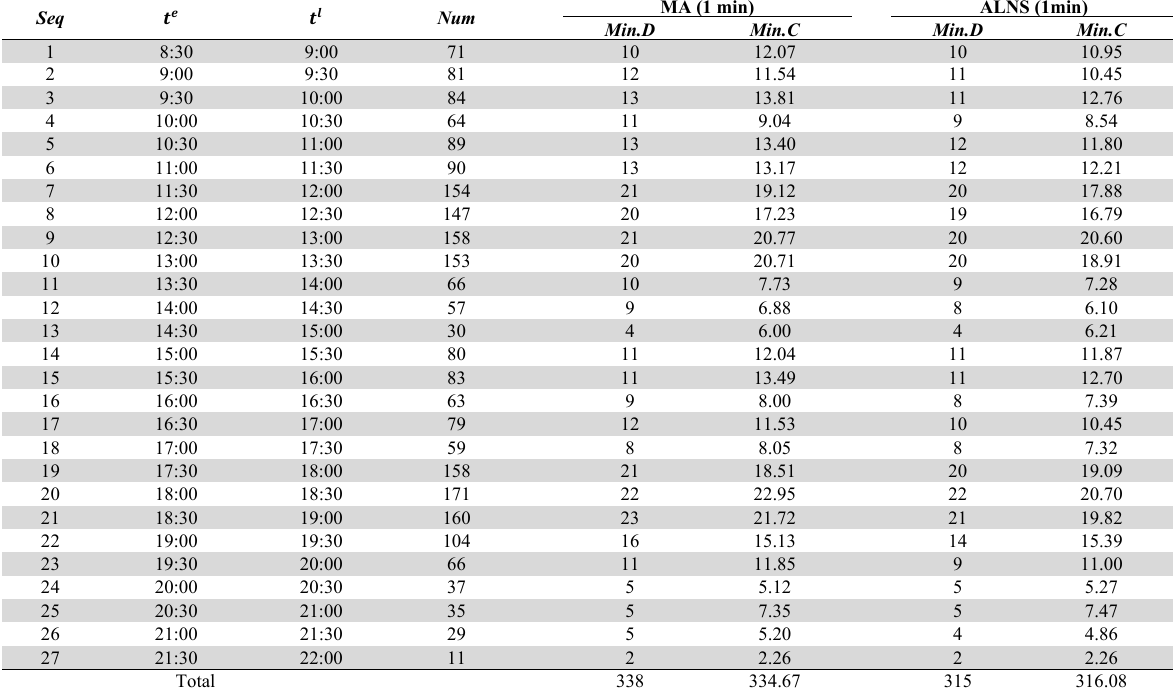
Table 4 Results of MPVRPD on a typical day